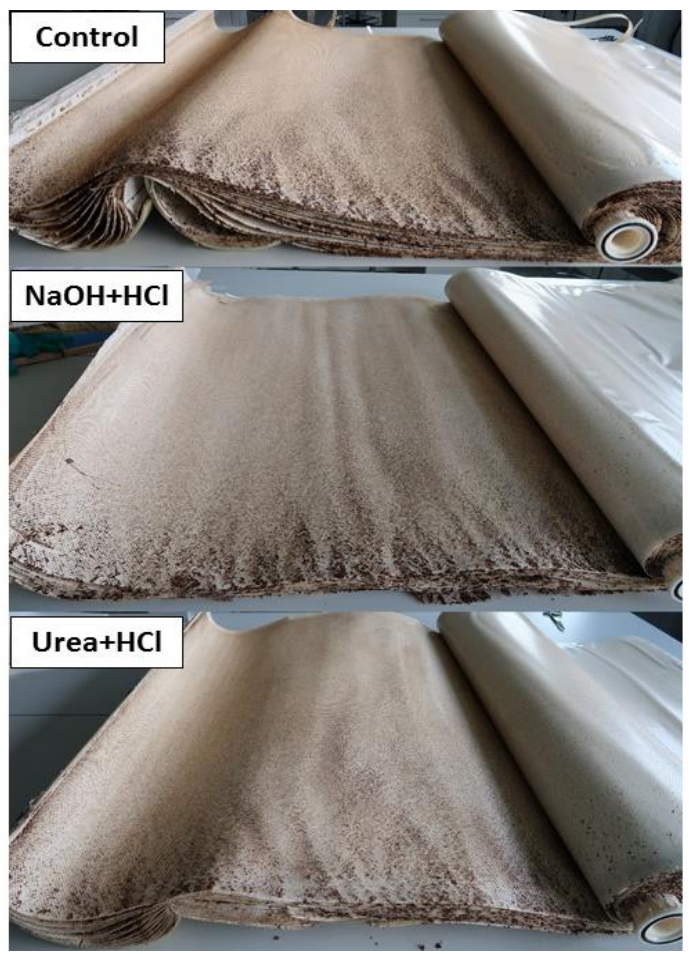
Figure 3. Visual comparison of the membrane/spacer surface of uncleaned (control) and cleaned membrane modules.